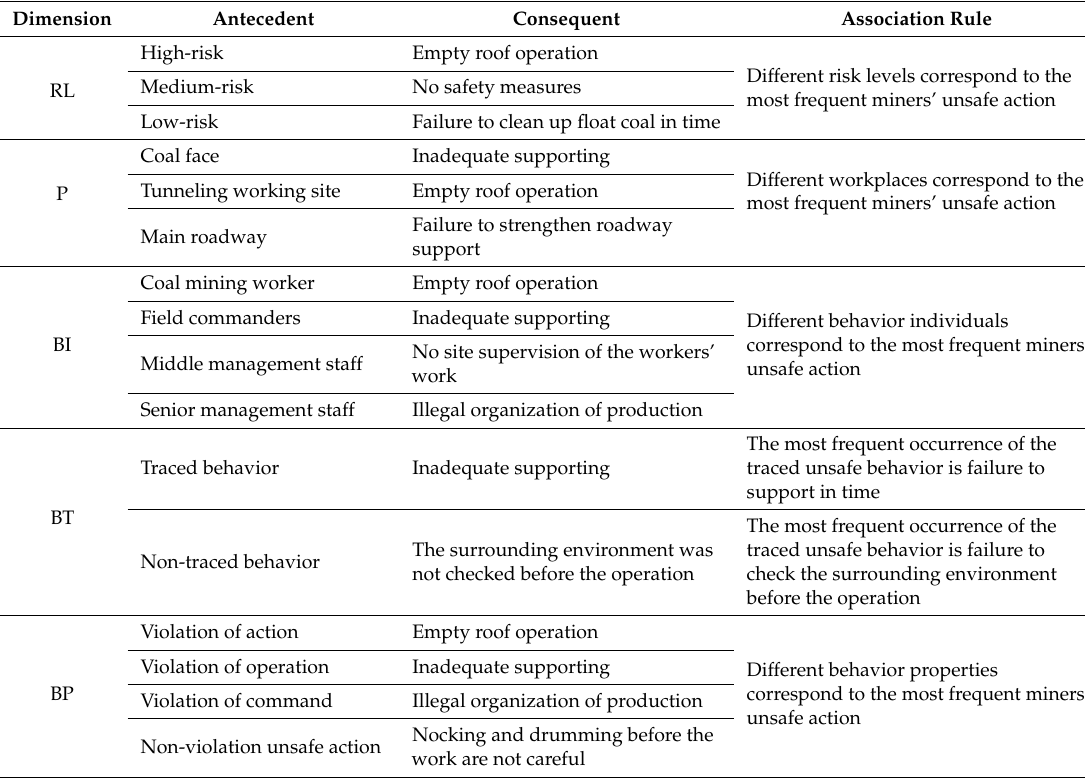
Table 2. Multidimensional interaction relationship